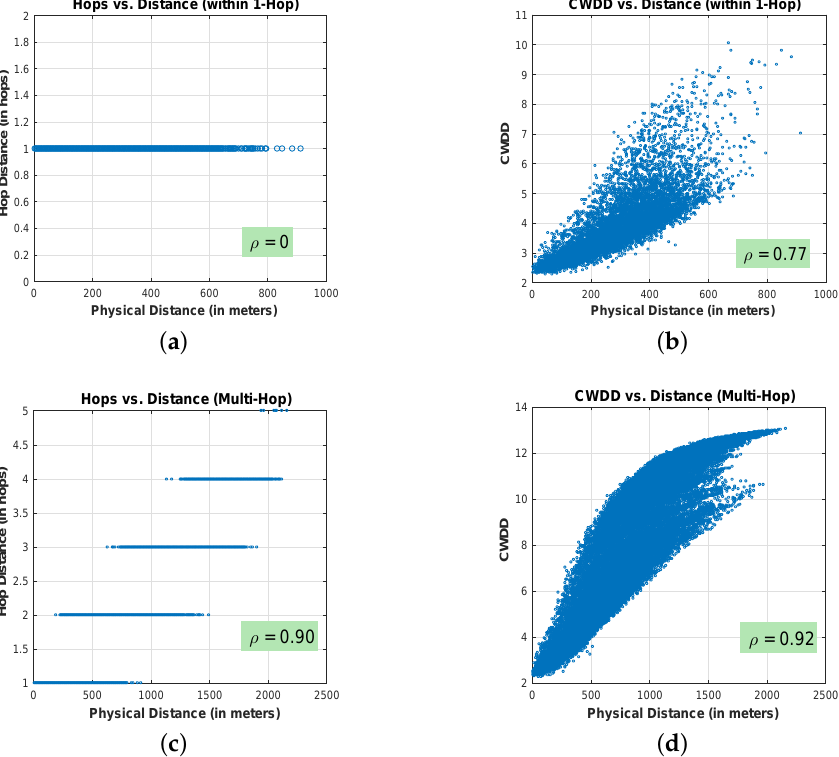
Figure 4. Distance correlation comparison: Hop vs. DD: ( a ) hops vs. distance (within 1-hop), ( b ) CWDD vs. distance (within 1-hop), ( c ) hops vs. distance (multi-hop), ( d ) CWDD vs. distance (multi-hop).